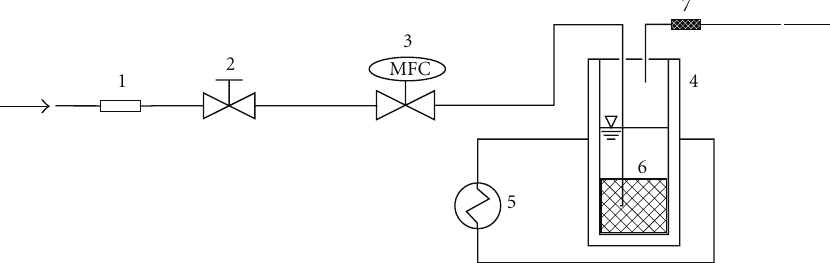
Figure 1: Bubbler system for the generation of test gas: (1) purifier with adsorbent, (2) flow regulator, (3) mass flow controller, (4) Impinger gas scrubber, (5) thermostat, and (6), (7) glass wool.